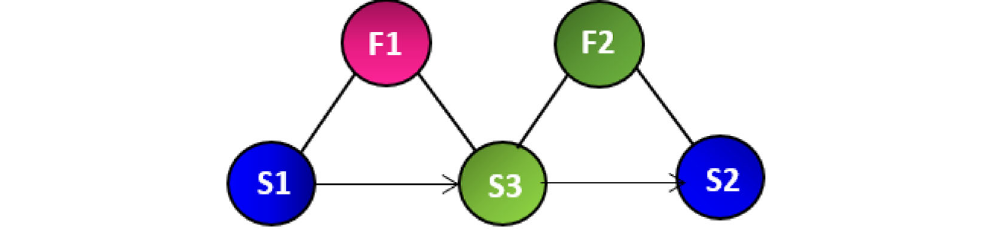
Figure 5. Chain Su-Field model with additional substance and